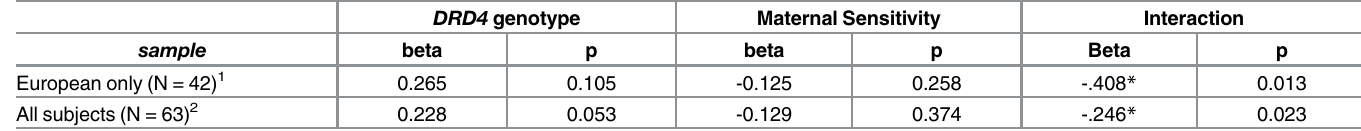
Table 2. Replication Analysis: Linear regression of effect of DRD4 genotype, maternal sensitivity, and their interaction on 18 month child External- izing Behavioral problems (Achenbach CBCL) § .